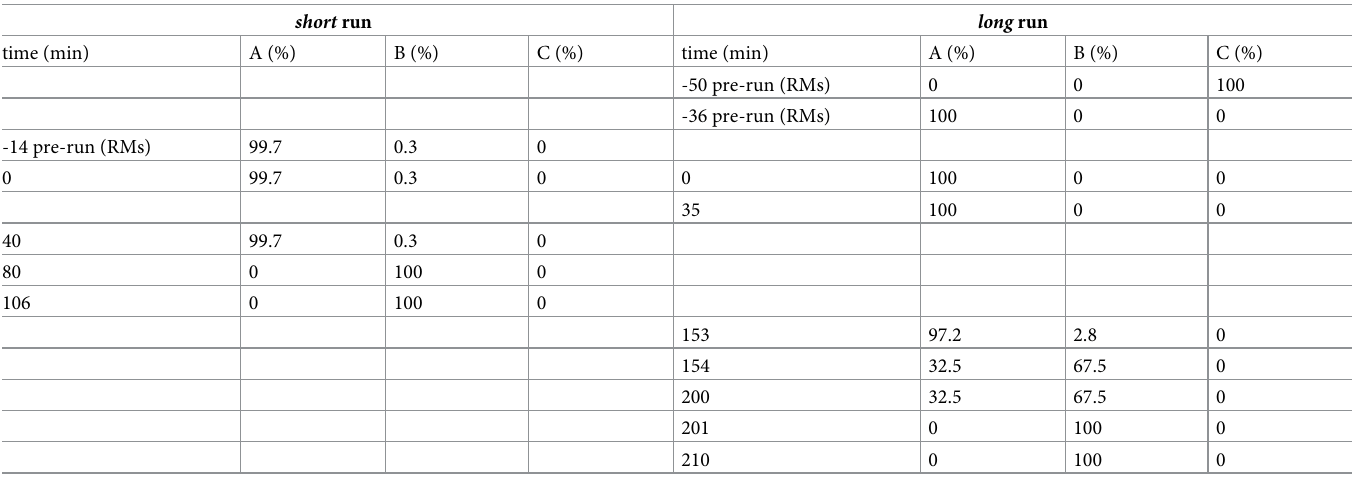
Table 1. Solvent compositions for short and long HPLC